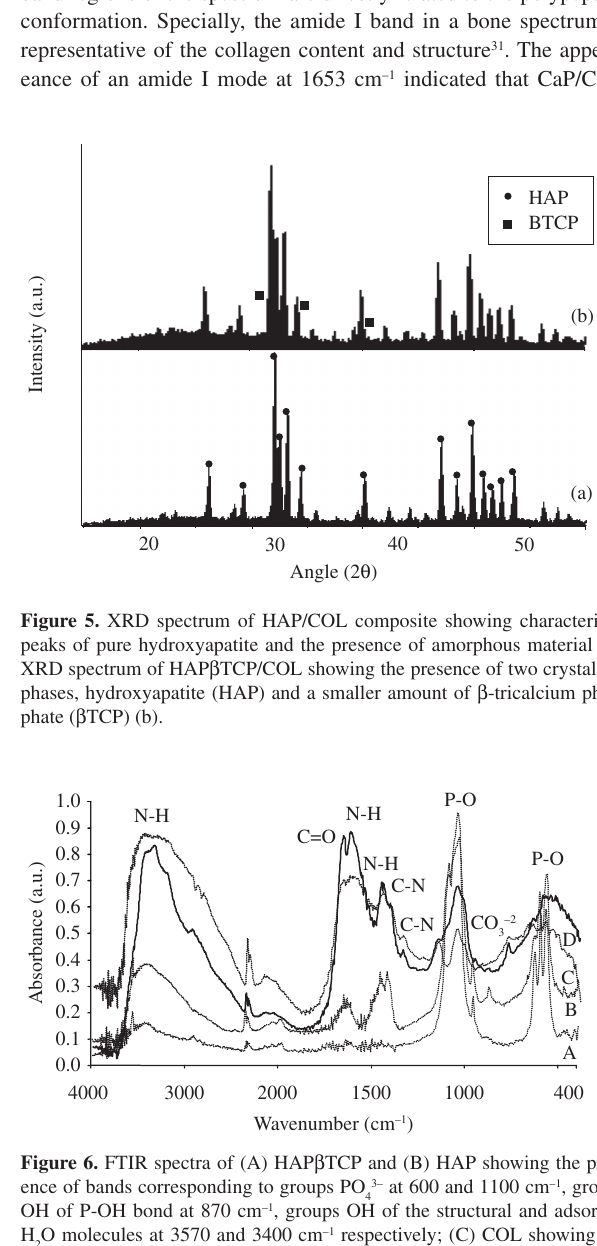
Figure 4. a) SEM photomicrograph of HAP particles aggregated to COL constituting the HAP/COL composite; and b) EDS spectra with elementary